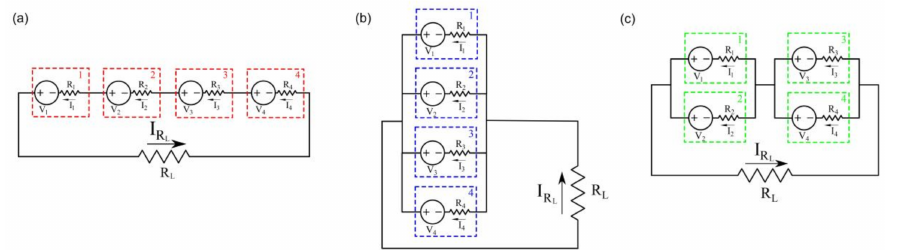
Figure 3. Schematic view of the electric connections for ( a ) series, ( b ) parallel and ( c ) square configu- rations (all cases correspond to an ATEG with 4